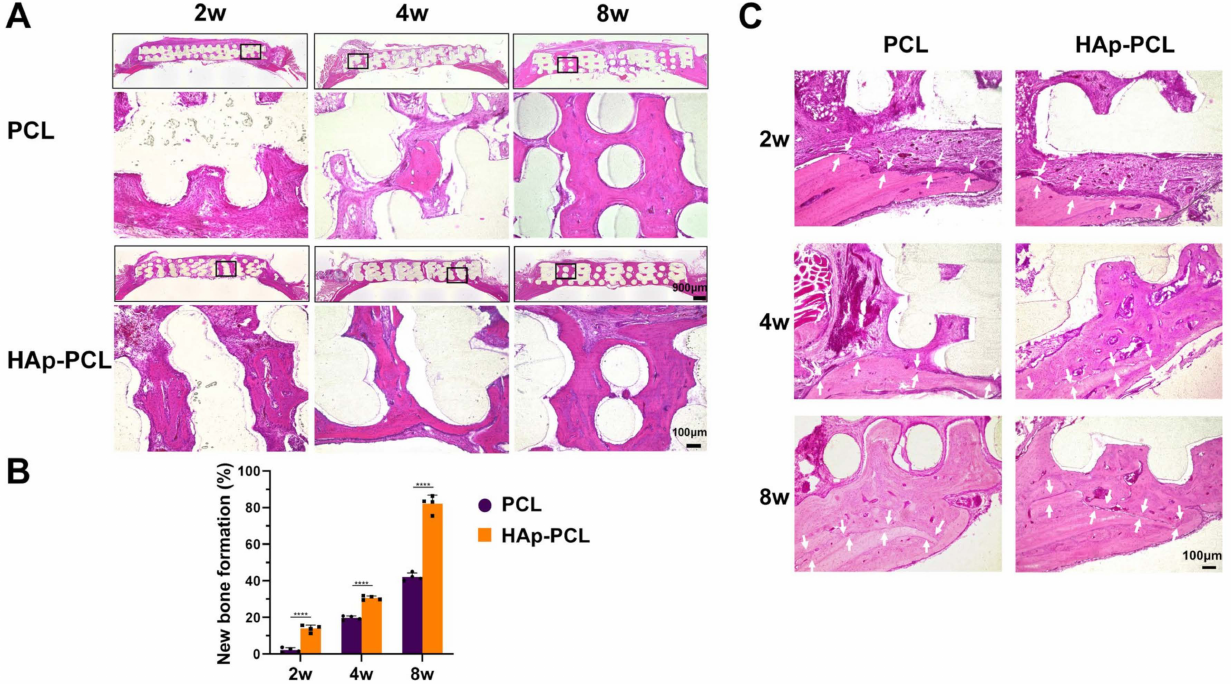
Figure 6. H&E staining for the sectioned tissue inside the scaffold at 2, 4, and 8 weeks after implanta- tion of PCL or HAp-PCL into the critical-sized calvaria bone defect in rats. ( A ) Representative staining images. The frames in the upper image indicate the region of lower image with high maginification. Scale bars are 100 (lower images) or 900 µ m (upper images). ( B ) Percentage of new bone area formed analyzed by the staining results. **** p < 0.0001: significant difference between two groups at the corresponding time. ( C ) Staining images of tissue surrounding the implant-host bone interface. The implant-host bone interface is present between two arrows. Scale bar is 100 µ